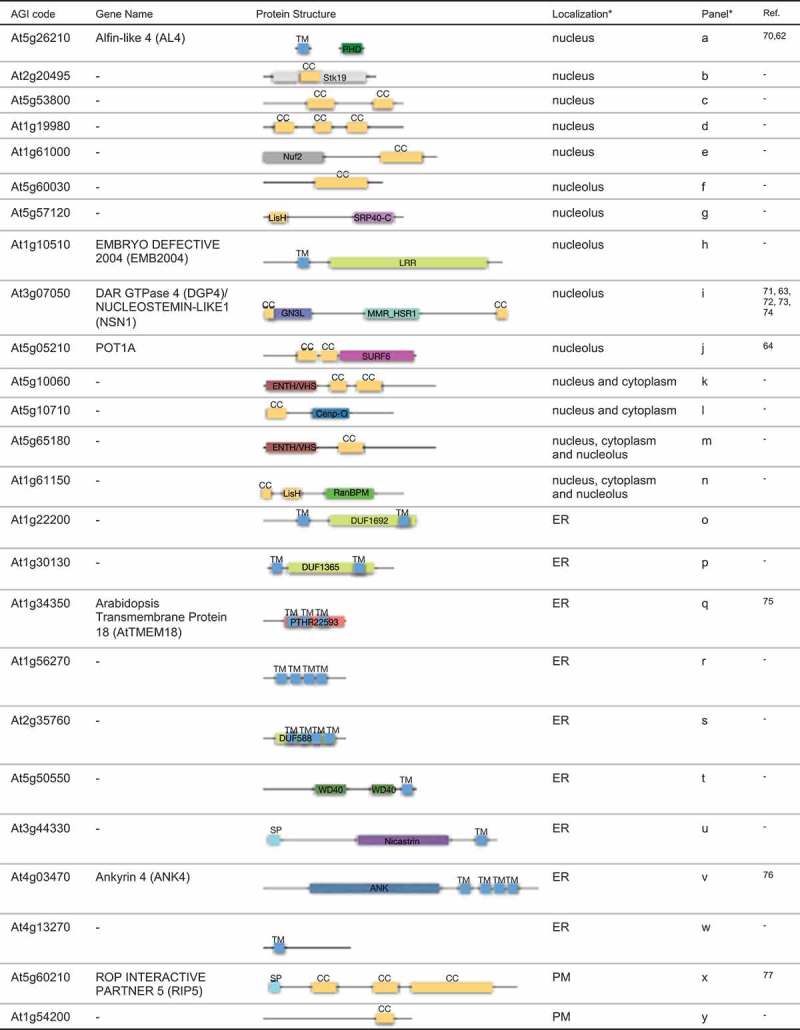
Schematic representation of predicted domain features of proteins characterized in this study. Localization analysis is shown in Figure S2. References are follows: 1[74].; 2[64].; 3[75].; 4[65].; 5[76].; 6[77]., 7[78].; 8[66].; 9[79].; 10[80].; 11[81].